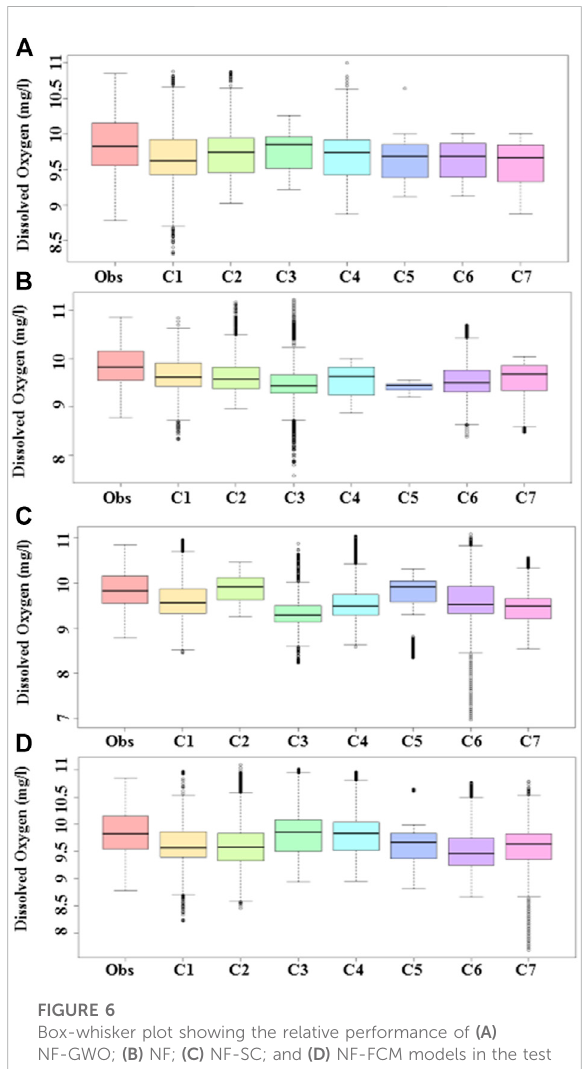
FIGURE 6 Box-whisker plot showing the relative performance of (A) NF-GWO; (B) NF; (C) NF-SC; and (D) NF-FCM models in the test phase at